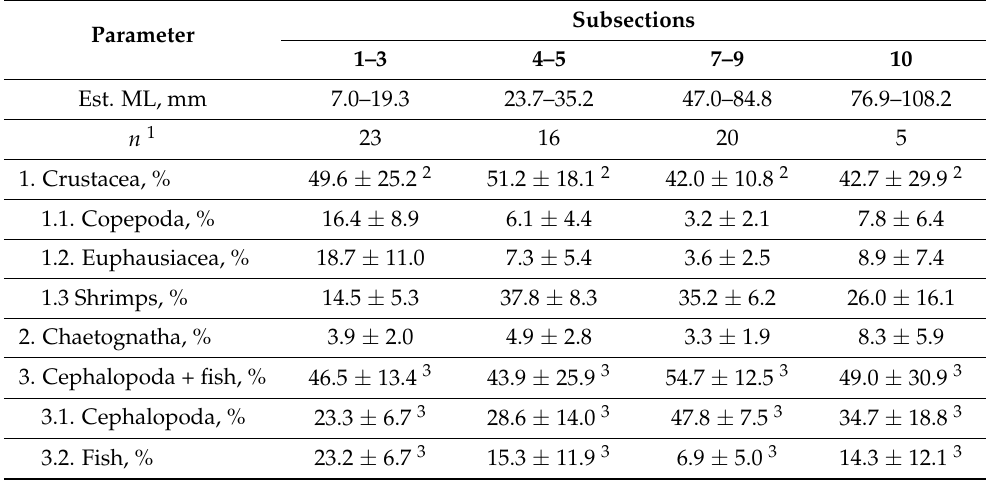
Figure 6. Relative contribution of prey to the diet (mean, box 25% and 75% percentiles, whiskers 5%, and 95% percentiles) in different upper beak subsections of Gonatus fabricii (as a proxy of different sizes) predicted by Bayesian mixing model SIMMR 0.4.5. Table 6. Relative contribution of prey to the diet in different upper beak subsections of Gonatus fabricii , predicted by Bayesian mixing model SIMMR 0.4.5. Relative contributions are mean ± SD. ML: mantle length, n : sample size, —: not